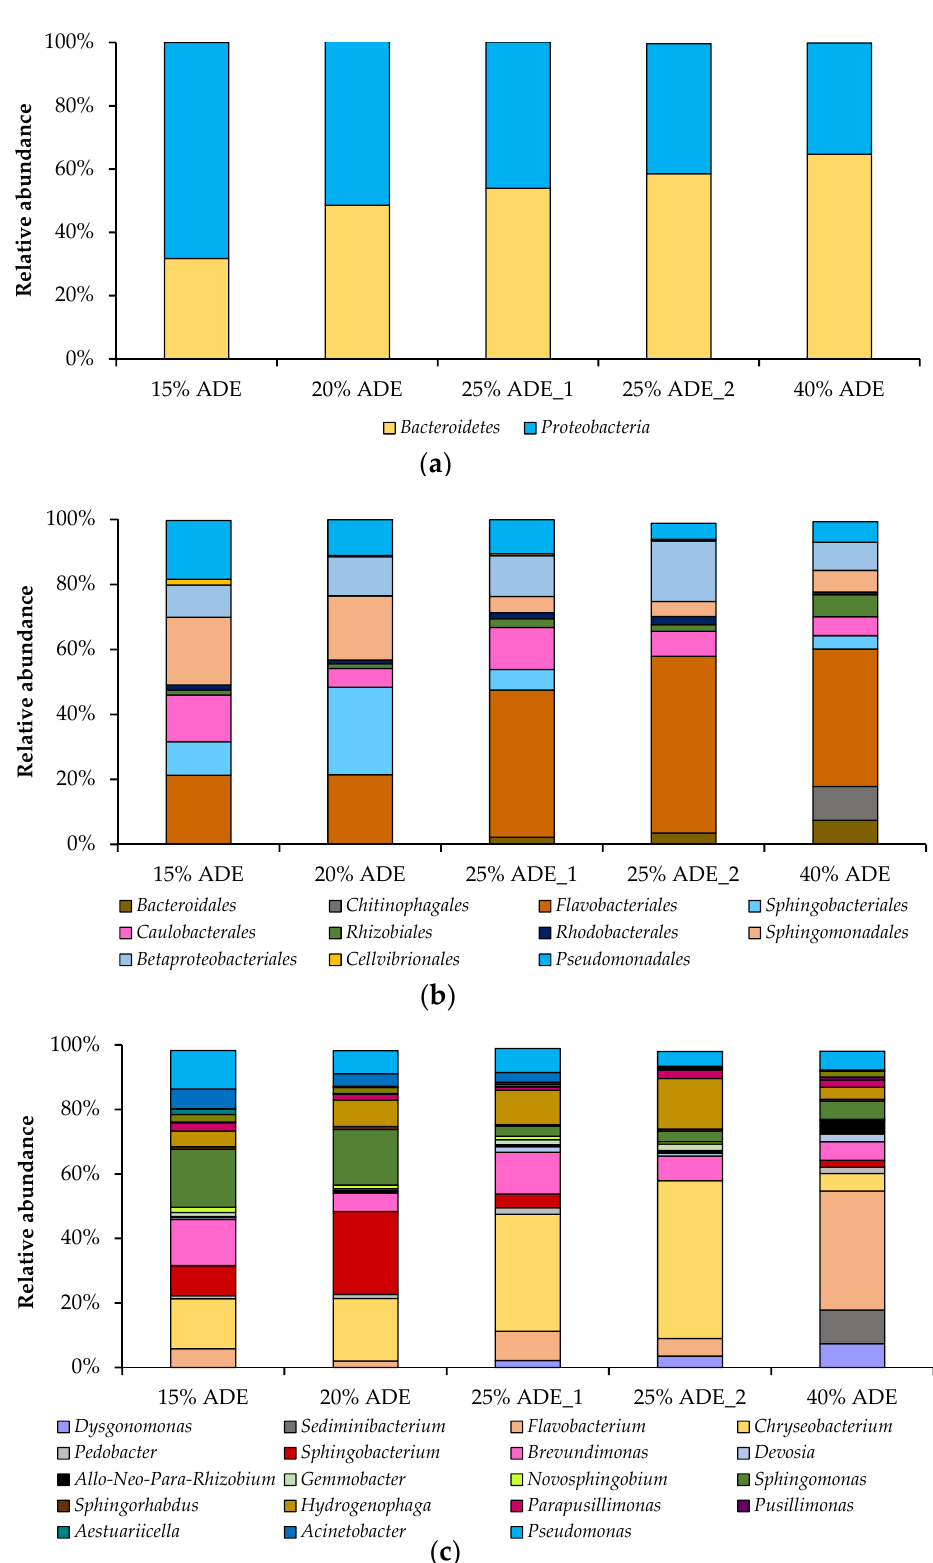
Figure 5. Taxonomic composition of bacterial communities in the bioreactor during C. sorokiniana AM ‐ 02 cultivation in ADE ‐ containing media (15% ADE (184 h), 20% ADE (184 h), 25% ADE_1 (160 h), 25% ADE_2 (208 h), and 40% ADE (208 h)). Bacterial community composition according to amplicon sequencing of the bacterial 16S rRNA gene is shown on the phylum ( a ), order ( b ), and genus ( c ) levels. Only genera with a relative abundance of at least 1% in at least one sample are shown.